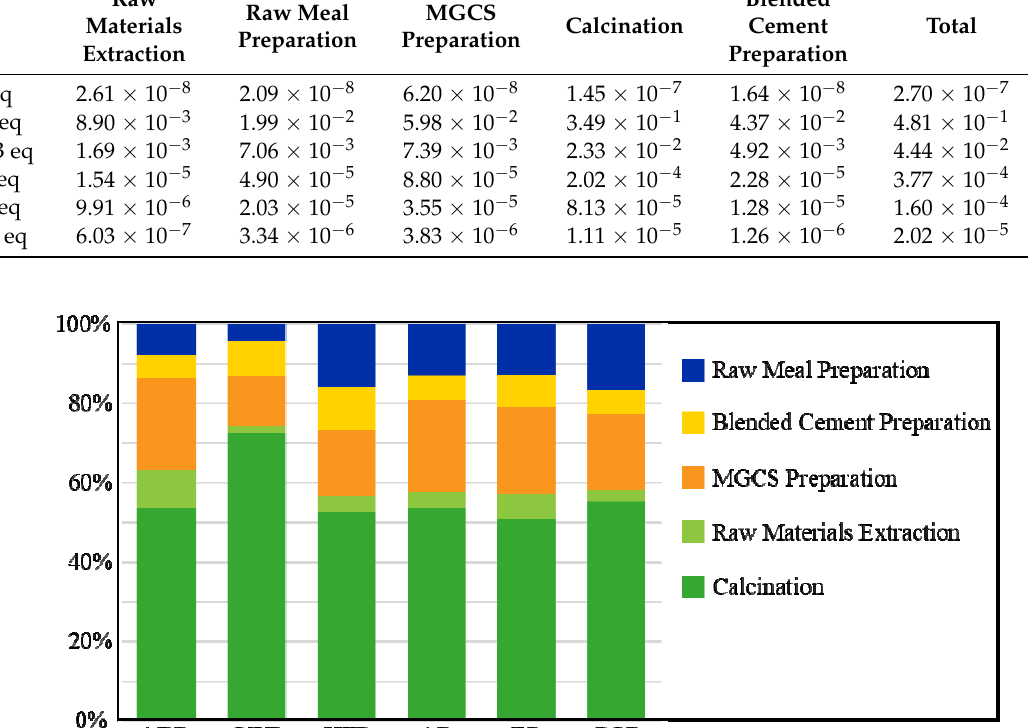
Figure 2. Environmental impacts of each stage to impact categories selected (characterization results).